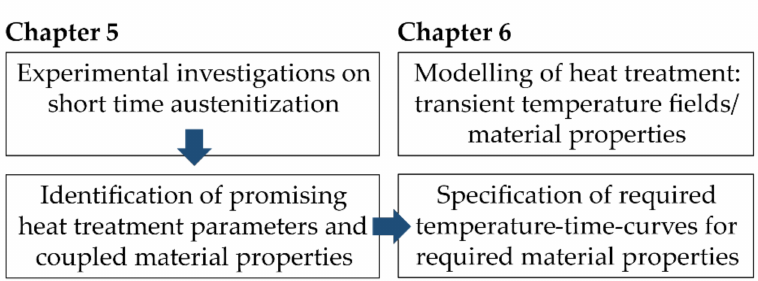
Figure 3. Combining experimental parameter determination and coupled thermal simula- tion/material simulation to realize a digital, simulation-based process